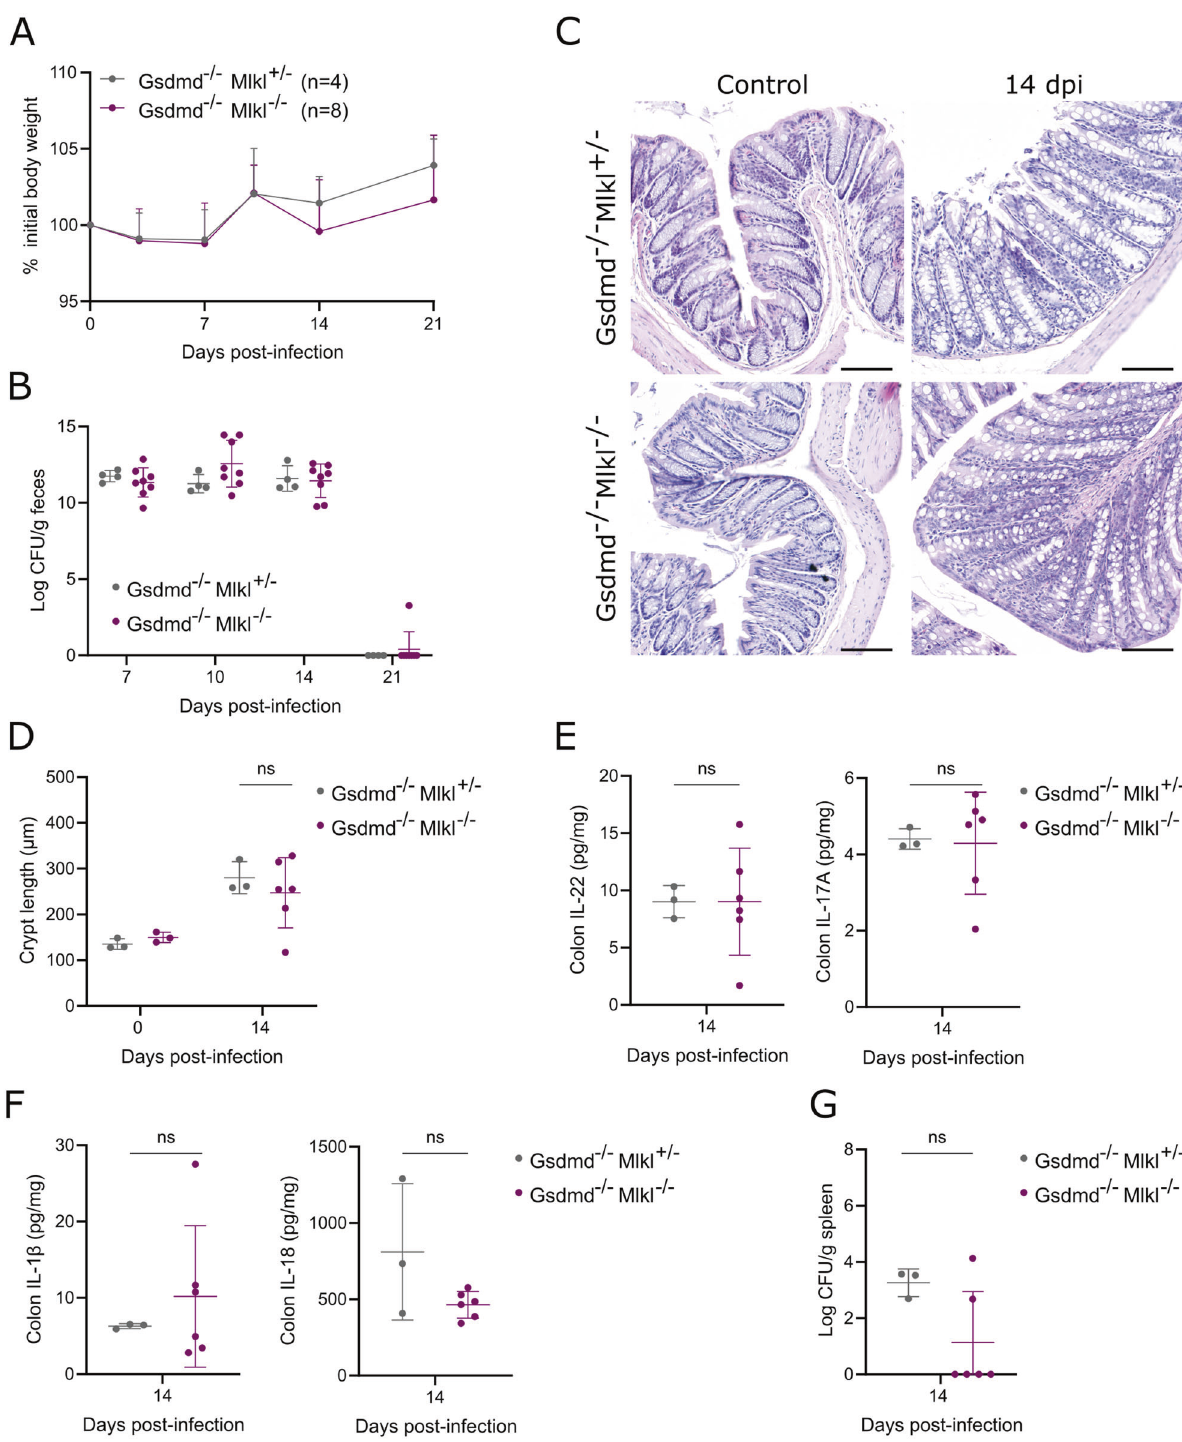
Fig. 4 Combined GSDMD and MLKL de fi ciencies do not impair host defense against gastrointestinal C. rodentium infection. Age- and sex- matched Gsdmd – / – Mlkl + /- ( n = 4) and Gsdmd – / – Mlkl – / – ( n = 8) littermates were infected by oral gavage with 5 × 10 9 CFU C. rodentium . A Weight change, and ( B ) fecal C. rodentium loads at indicated dpi are shown. Data in ( A ) represent means + SD; data in ( B ) represent individual mice and their means ± SD. ( C-G ) Age- and sex-matched Gsdmd – / – Mlkl + /- ( n = 3) and Gsdmd – / – Mlkl – / – ( n = 6) littermates were infected by oral gavage with 5 × 10 9 CFU C. rodentium and were sacri fi ced at 14 dpi, along with non-infected control Gsdmd – / – Mlkl + /- ( n = 3) and Gsdmd – / – Mlkl – / – ( n = 3) littermates. C Representative colon H&E stainings and D colon crypt length measurements; E colon IL-22 and IL-17 levels; F colon IL-1 β and IL-18 levels; and G splenic C. rodentium loads. All data points in ( D – G ) represent individual mice along with means ± SD. Scale bars ( C ) 100 µm.